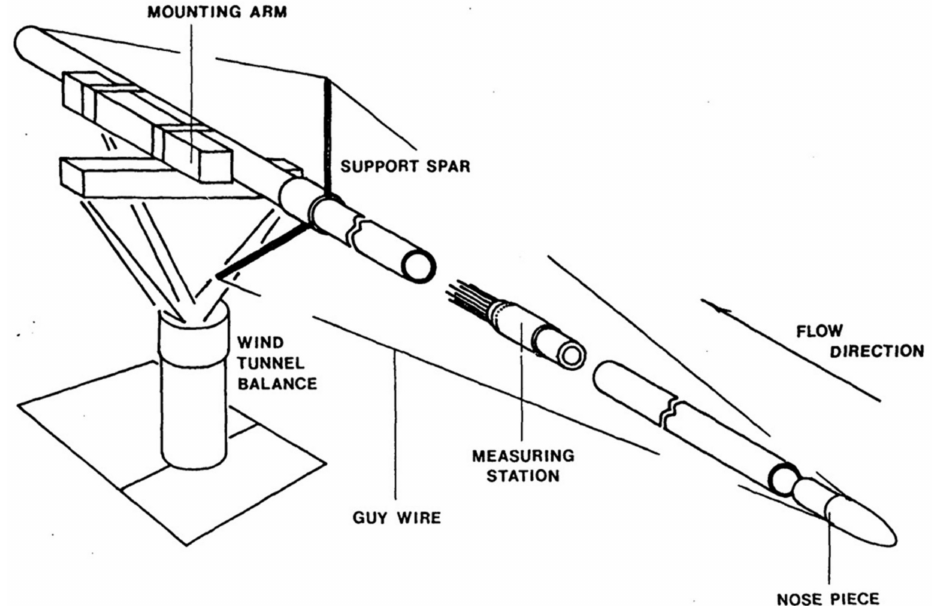
Figure 1. Schematic diagram of the cylinder assembly. The flow was obliquely right-to-left as indicated. Pressure taps appeared as a ring of dots toward the aft of the measuring station; the lines extending back from the measuring station represent the connectors to which the flexible pressure lines were